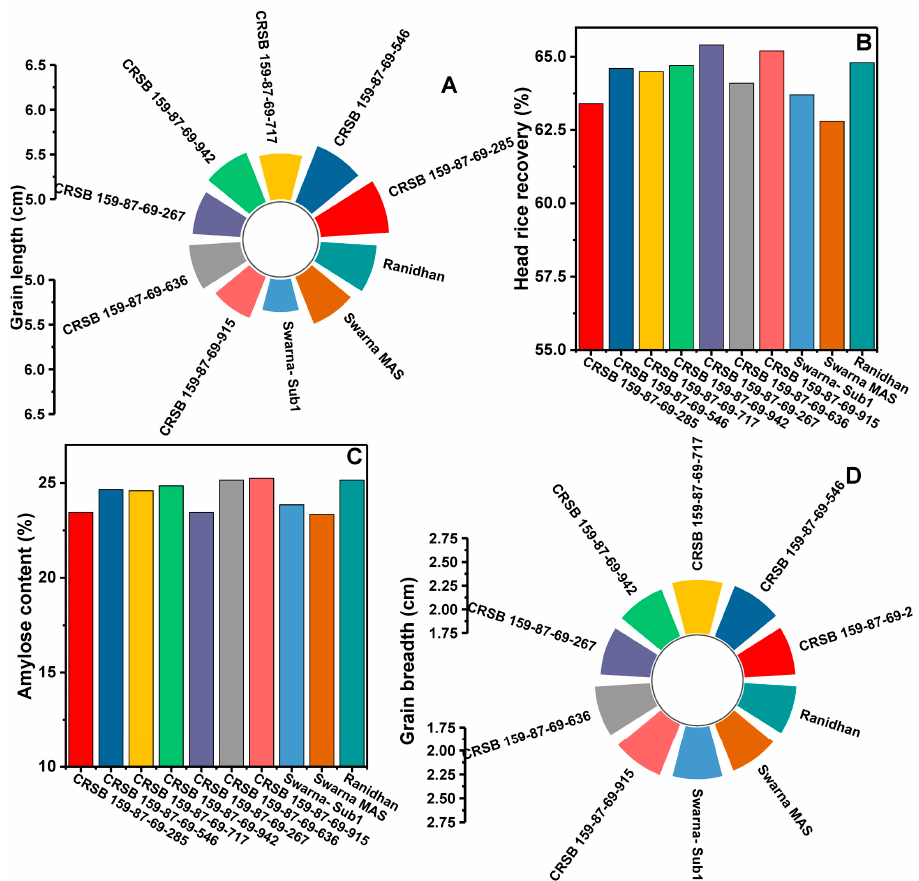
Figure 10. Diagrammatic representation of similarity of the pyramided and parental lines for quality traits ( A ) grain length, ( B ) head rice recovery, ( C ) amylose content, and ( D ) grain breadth.